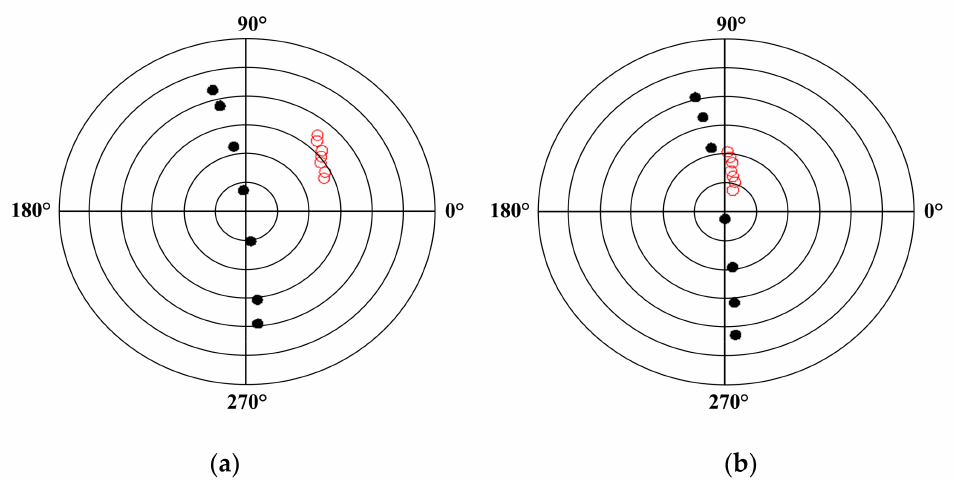
Figure 1. MODIS angular sampling within 2021.101-116 ( a ) and 305-320 ( b ). The radius represents the zenith angle with an interval of 15 ◦ , and the polar angle represents the azimuth. Solid dots represent the locations of the view, and the open circles refer to the locations of the